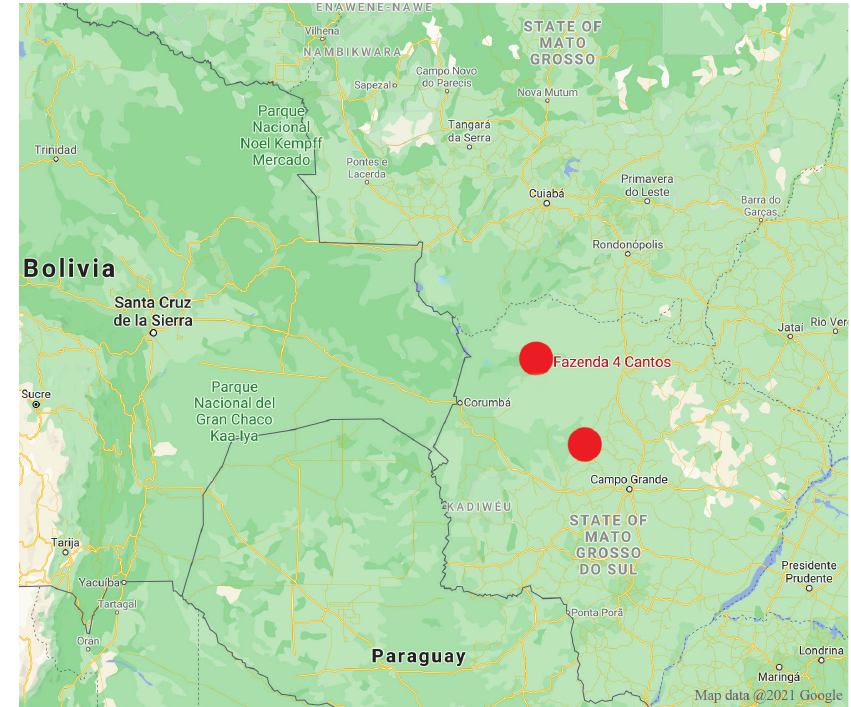
Figure 5. Location of type localities of Fazenda 4 Cantos and Fazenda Natureza, Mato Grosso do Sul,